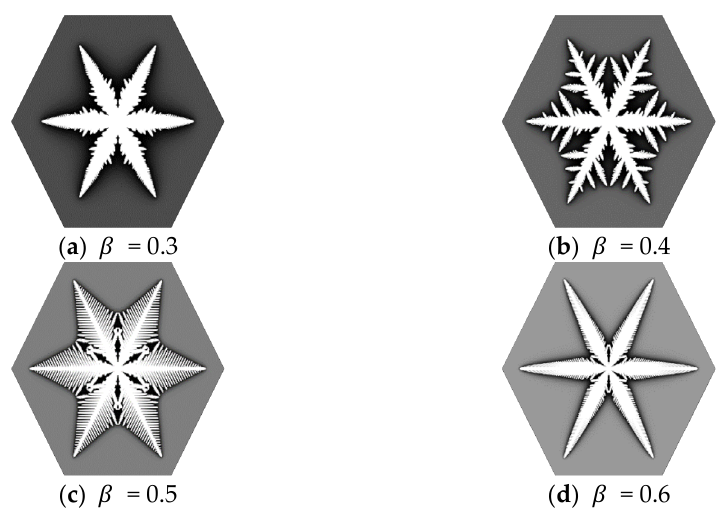
when the vertical growth parameter γ is set to a constant 0.001.